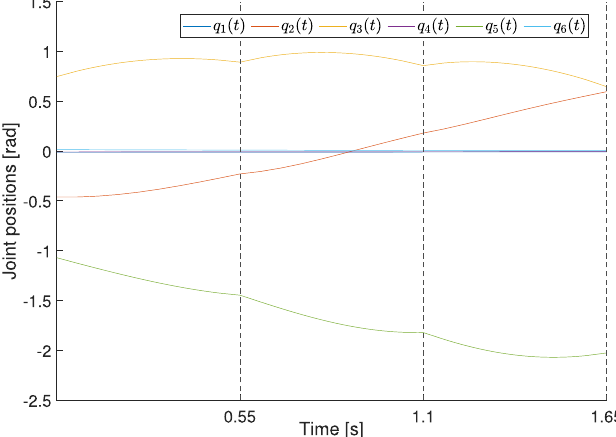
Fig. 7. Planned joint positions with fi xed slide for the trajectories 1 – 3 plotted in sequence. The end of each trajectory is indicated with a dotted line.